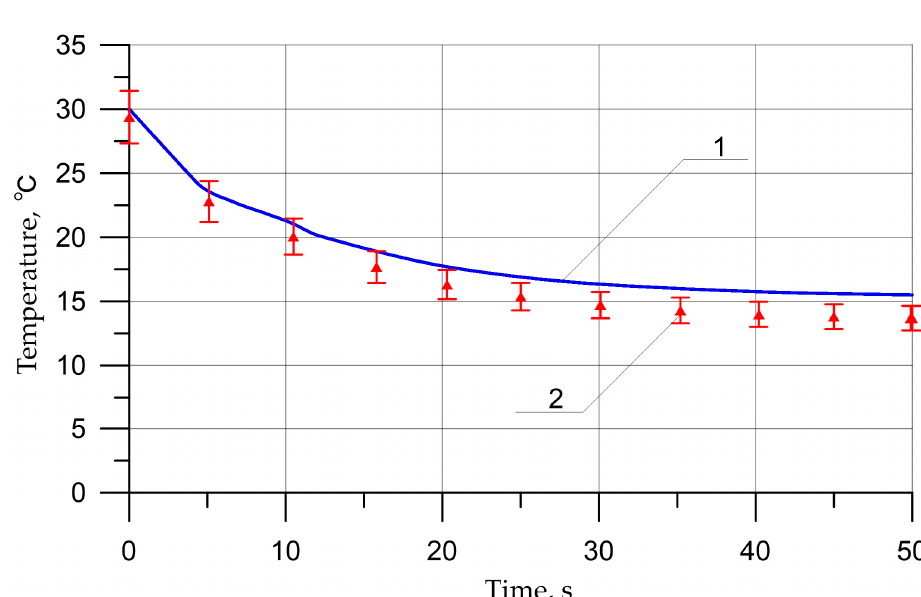
Figure 16. Number of particles over time.